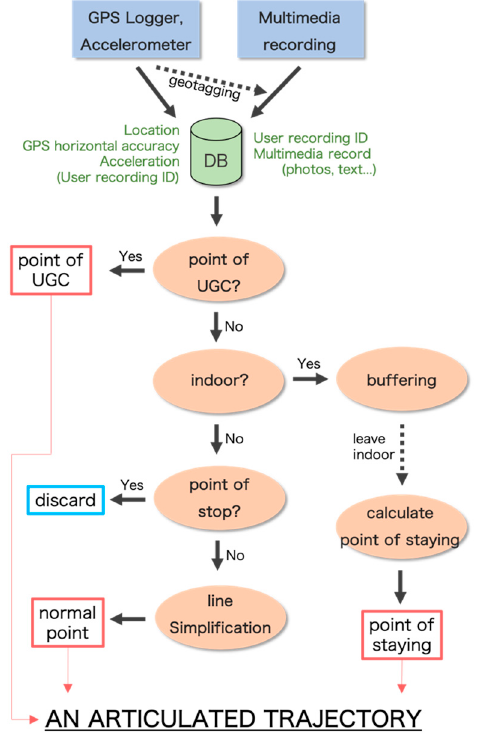
Figure 3. Flow of generating articulated trajectory data from raw trajectory data as human-centered readable spatial content.